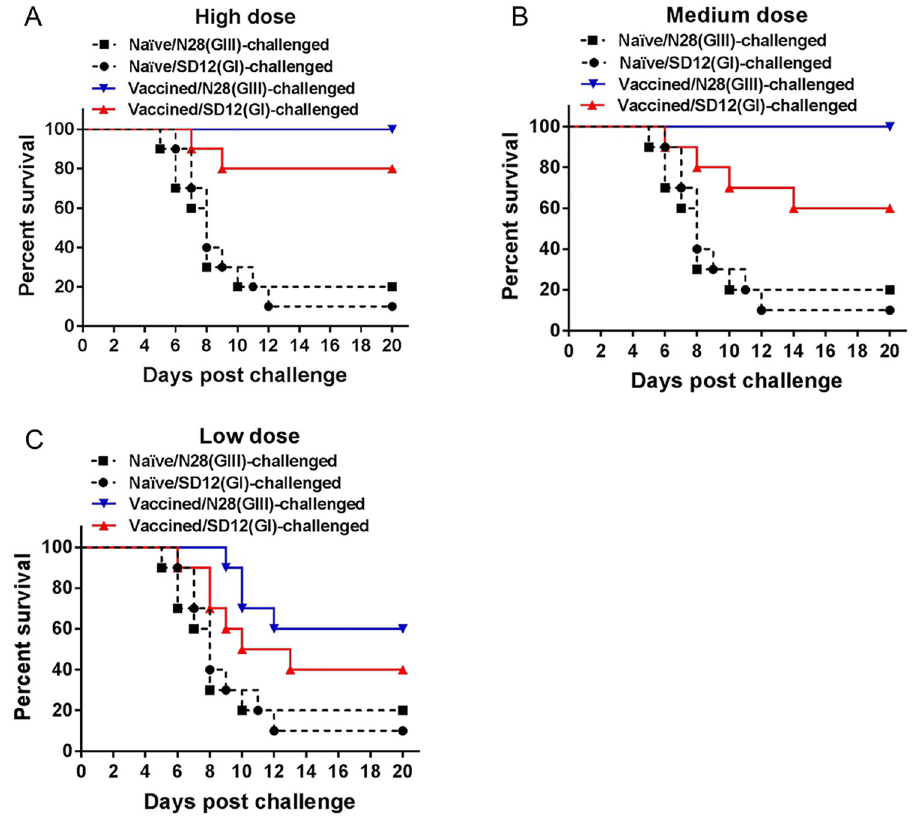
Fig 2. Protective efficacy of the SA14-14-2 vaccine. Mice ( n = 10) were mock-vaccinated (Na ï ve) or immunized with SA14-14-2 vaccine at high (5000 PFU) dose (A), medium (500 PFU) dose (B), and low (50 PFU) dose and challenged with the indicated JEV